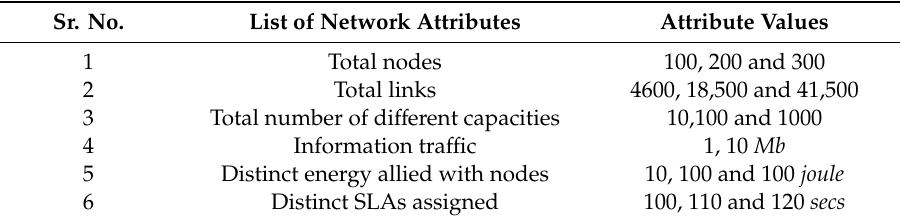
Table 1. Estimations of several network metrics for arbitrary